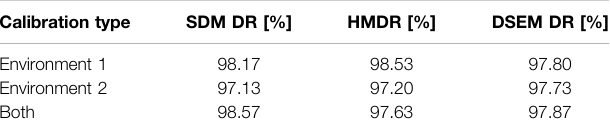
TABLE 7 | Testing phase. Mean value of DR for tests performed in Environment 1 versus calibration type.